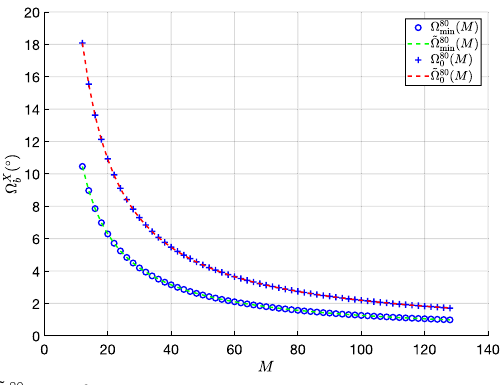
Fig. 6 � 80 min / 0 ( M ) and